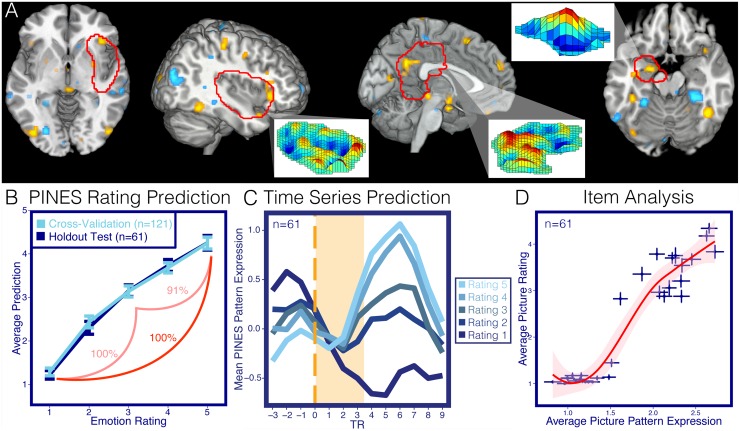
PINES.Panel A depicts the PINES pattern thresholded using a 5,000 sample bootstrap procedure at p < 0.001 uncorrected. Blowout sections show the spatial topography of the pattern in the left amygdala, right insula, and posterior cingulate cortex. Panel B shows the predicted affective rating compared to the actual ratings for the cross validated participants (n = 121) and the separate holdout test data set (n = 61). Accuracies reflect forced-choice comparisons between high and low and high, medium, and low ratings. Panel C depicts an average peristimulus plot of the PINES response to the holdout test dataset (n = 61). This reflects the average PINES response at every repetition time (TR) in the timeseries separated by the rating. Panel D illustrates an item analysis which shows the average PINES response to each photo by the average ratings to the photos in the separate test dataset (n = 61). Error bars reflect ±1 standard error.